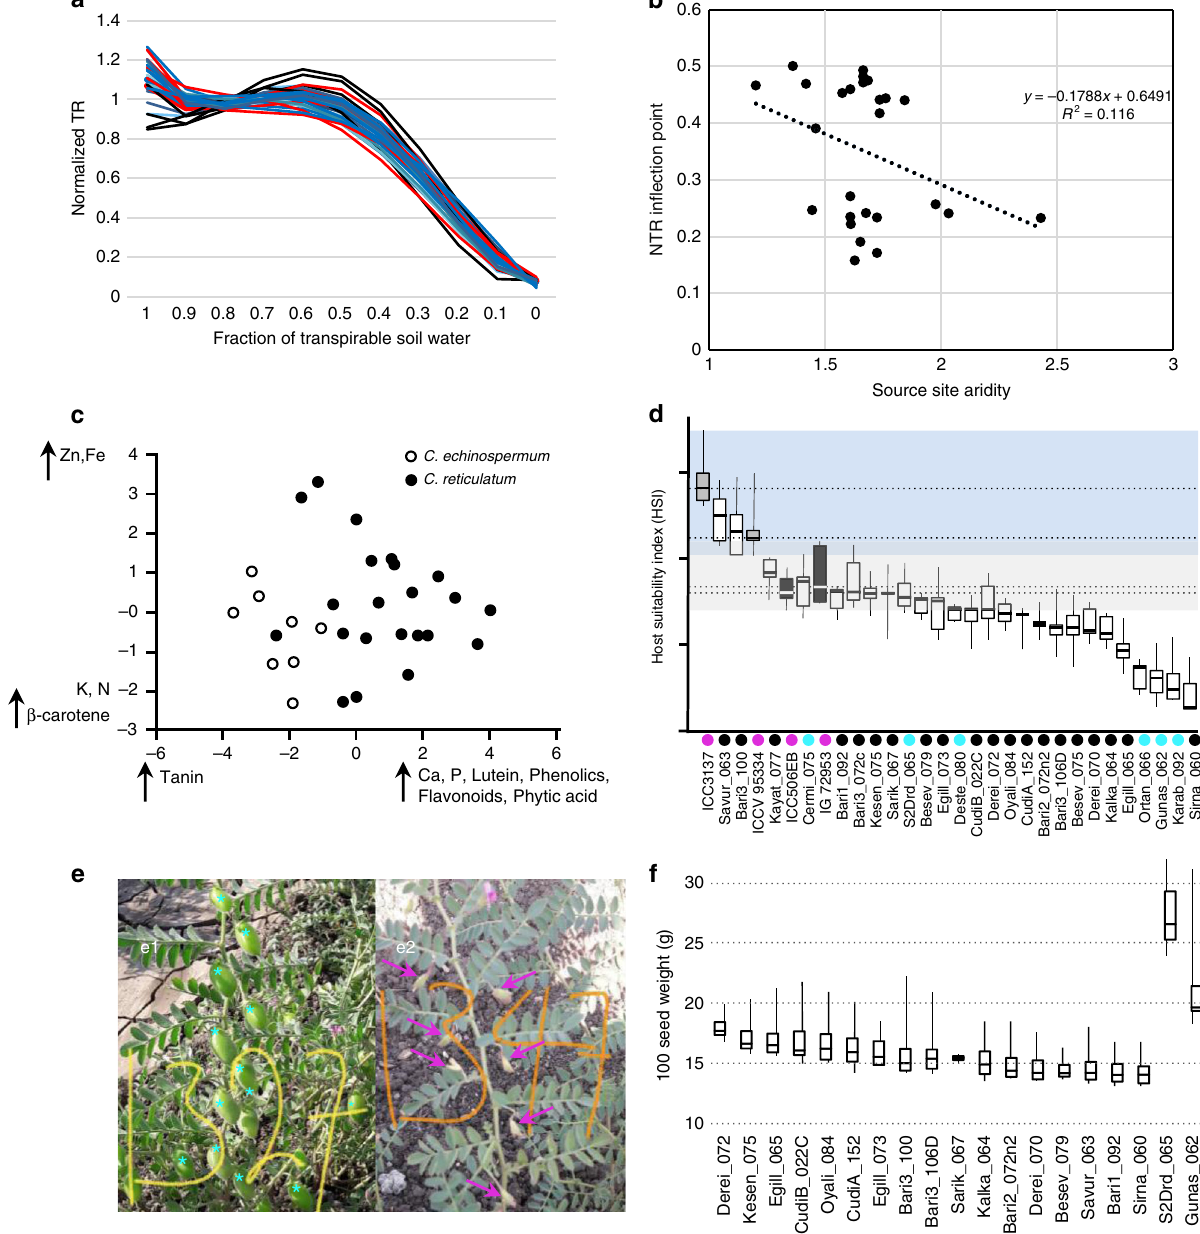
Fig. 6 Variation in agronomically important traits in wild Cicer . a Relationship between the normalized transpiration ratio (NTR) and the fraction of transpirable soil water (FTSW) of twenty-six wild Cicer genotypes and four chickpea cultivars under a scenario of declining soil moisture. Black, cultivated C. arietinum ; blue, C. reticulatum ; red, C. echinospermum . b In fl ection point (second derivative of the 4th order polynominal) of the relationship between normalized transpiration rate (NTR) and FTSW against the aridity (precipitation/potential evapotranspiration) of the source site of the 26 wild lines. c Principal component analysis of seed nutrient content. d Host suitability index for Helicoverpa armigera for 26 wild lines and four previously characterized susceptible and resistant accessions from the ICRISAT genebank. Green, tolerant and susceptible checks; red, C. echinospermum ; blue, C. reticulatum . e F3 families segregate at high frequency for heat stress tolerance in phenology-normalized lines; typical phenotypes of tolerance (e1)(seed set, blue asterisk) and sensitivity (e2)( fl ower abortion, red arrows) when grown under high temperatures during March to May in Hyderabad, India. f One-hundred seed weight variation among F3 progeny for 19 wild accessions crossed to a recurrent cultivated parent (ICCV96029). Plants were grown in a common fi eld garden. Error bars are standard deviations in panels d and